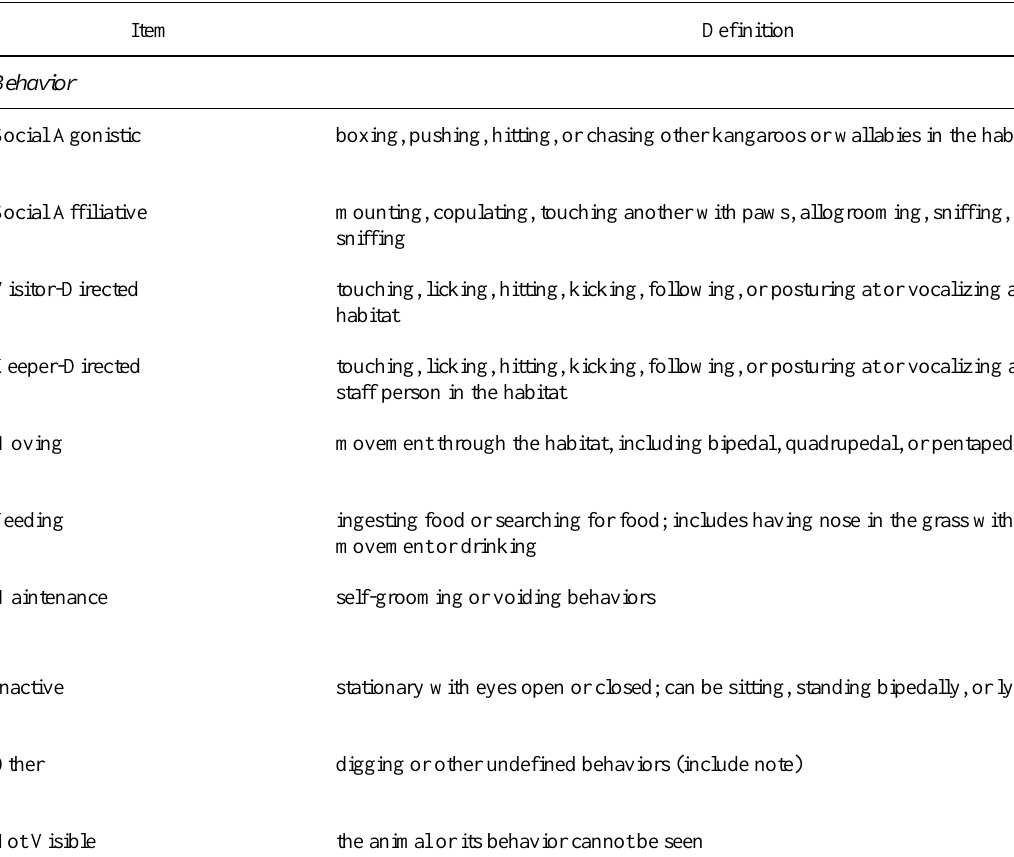
Ethogram of Behavior, Path Proximity, and Social